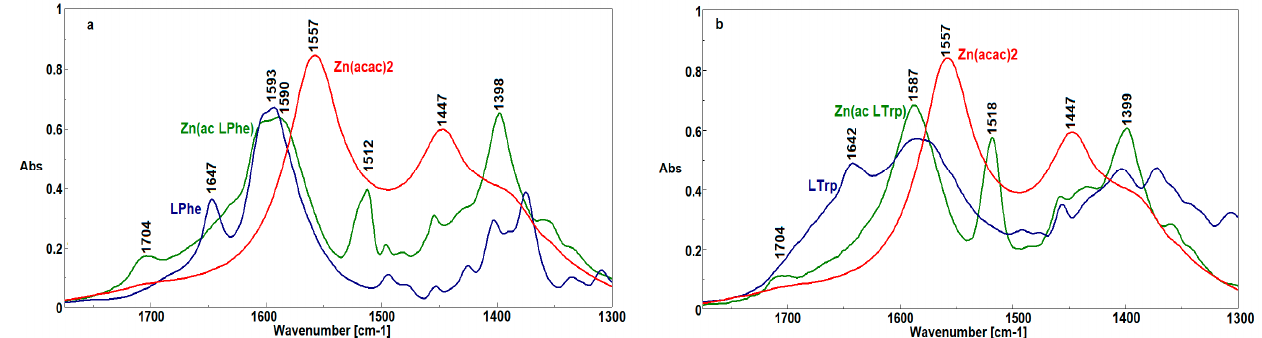
Figure 5. FTIR spectra of Zn[(acac)(LPhe)H 2 O], Zn[(acac) 2 H 2 O], and HPhe ( a ), and Zn[(acac)(LTrp) H 2 O], Zn(acac) 2 H 2 O], and HTrp ( b ).